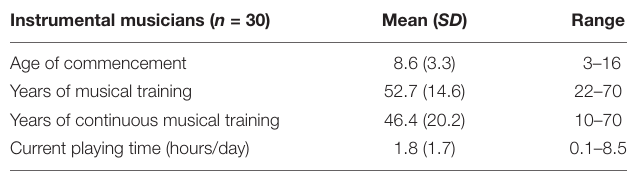
TABLE 2 | Musical instrument training status in